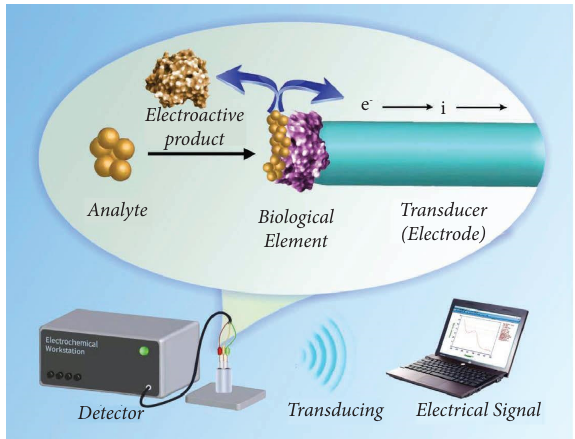
Figure 1: Basic analytical scheme of an enzyme-modifed elec- trochemical